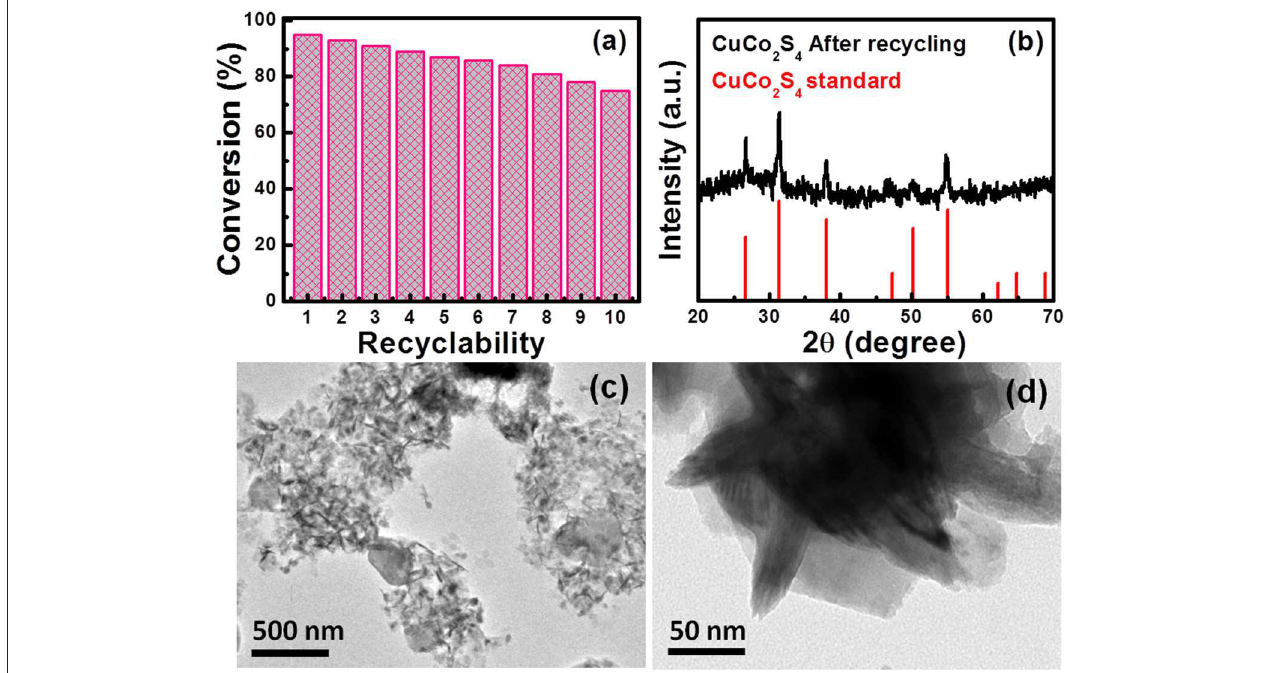
FIGURE 4 | (a) Recycling study of CuCo 2 S 4 catalyst for the synthesis of diphenylacetylene. (b) powder XRD pattern of CuCo 2 S 4 nanosheet sample after performing 10 catalytic cycles. (c,d) Low and high magnification images of spent catalysts.